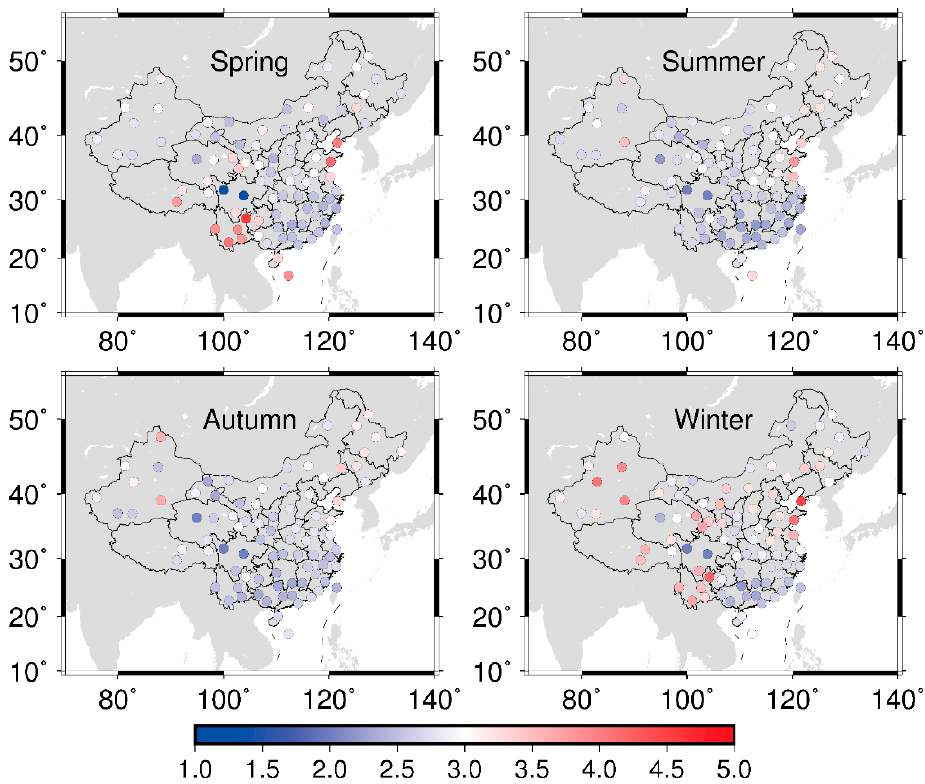
Figure 2. The values of the coefficient ω in different seasons calculated from the radiosonde profiles.